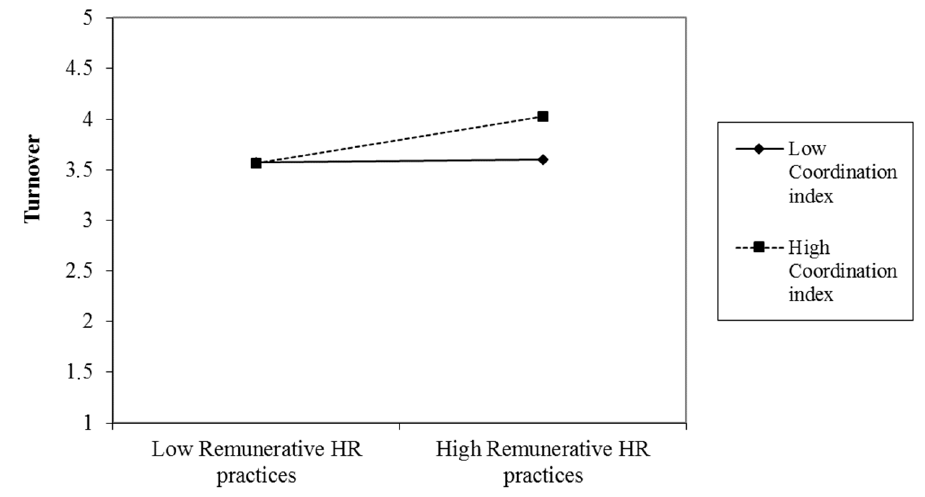
Figure 2. Interaction of country coordination index with company HR remunerative practices on collective turnover.